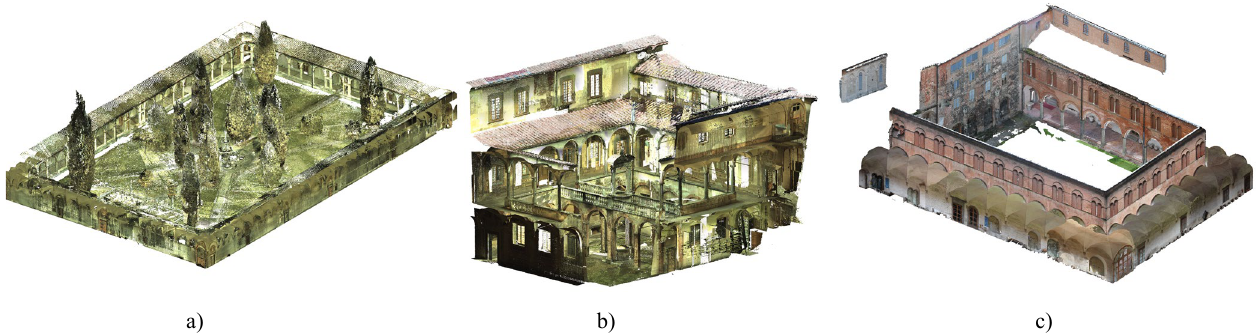
Figure 2. The case studies analyzed in this work: the Grand cloister (a, 10 M points) and the Grand-Ducal cloister (b, 6M points) of Pisa Charterhouse and the cloister of the National Museum of San Matteo (c, 12 M